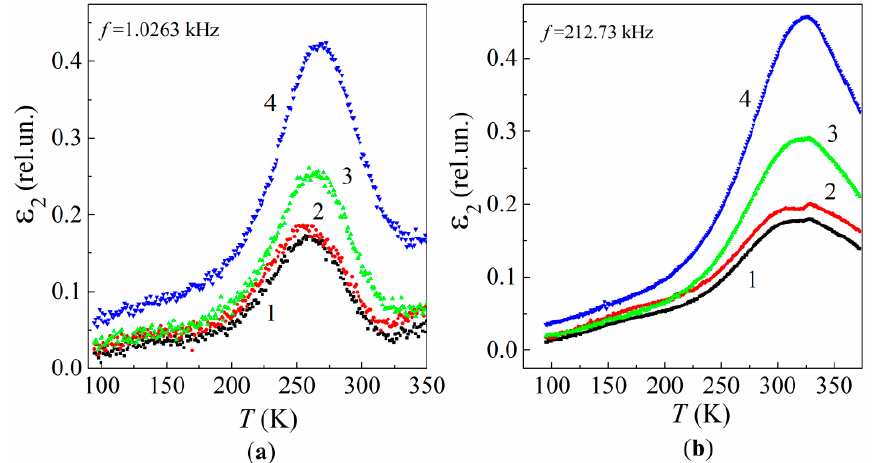
Figure 14. Temperature dependences of the relative dielectric loss factor at frequencies 1.0263 kHz ( a ) and 212.73 kHz ( b ) for the neat epoxy (1) and MLG composites of 1% (2), 2% (3), and 5% (4) MLGs.